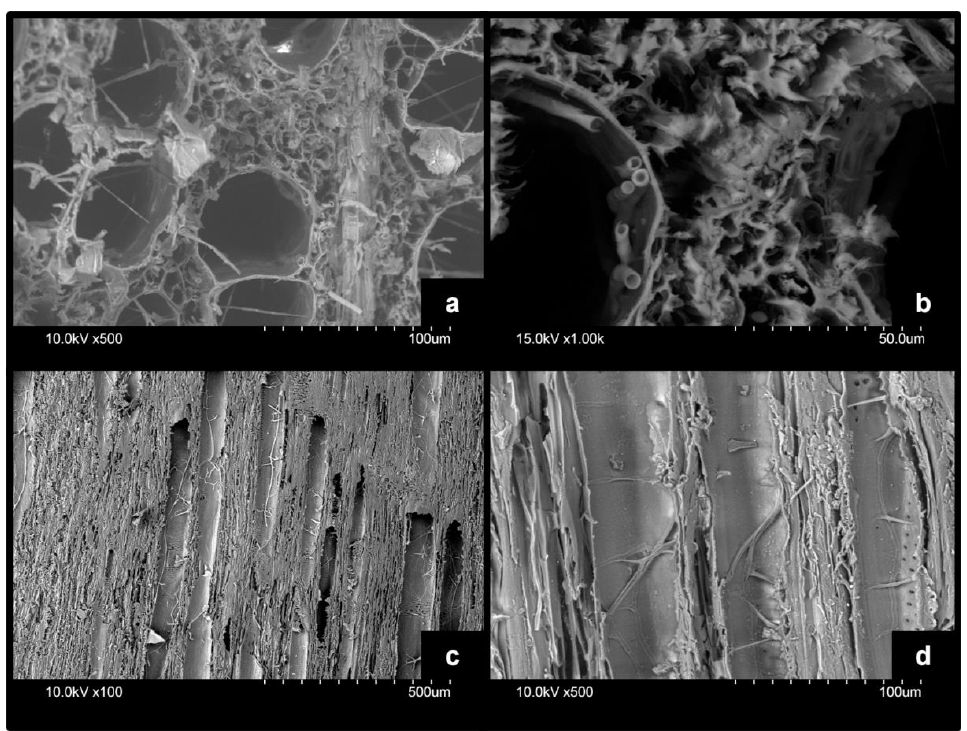
Figure 7. SEM pictures of cross section (above) and longitudinal section (below) of decayed beech wood: ( a ) fibrous tissue, ( b ) hyphae in lumen, ( c ) damaged bordered pits, ( d ) growing hyphae along vessels.